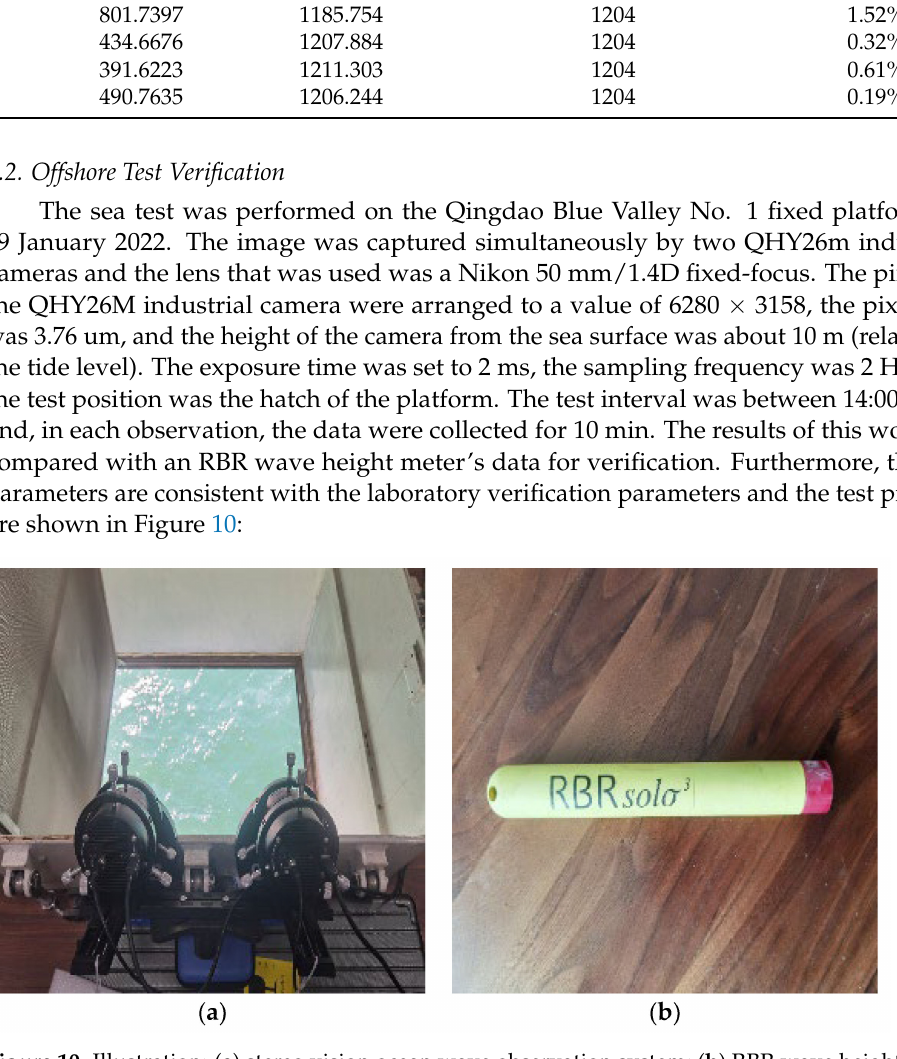
Figure 10. Illustration: ( a ) stereo vision ocean wave observation system; ( b ) RBR wave height meter. The size of the field was X min = − 1500 mm, X max = 1000 mm, Y min = − 1000